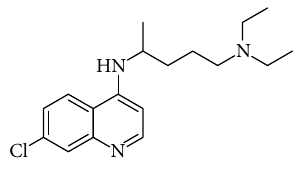
Figure 5: Molecular graph of Chloroquine. Table 2: Edge partitioning based on degree of Chloroquine.